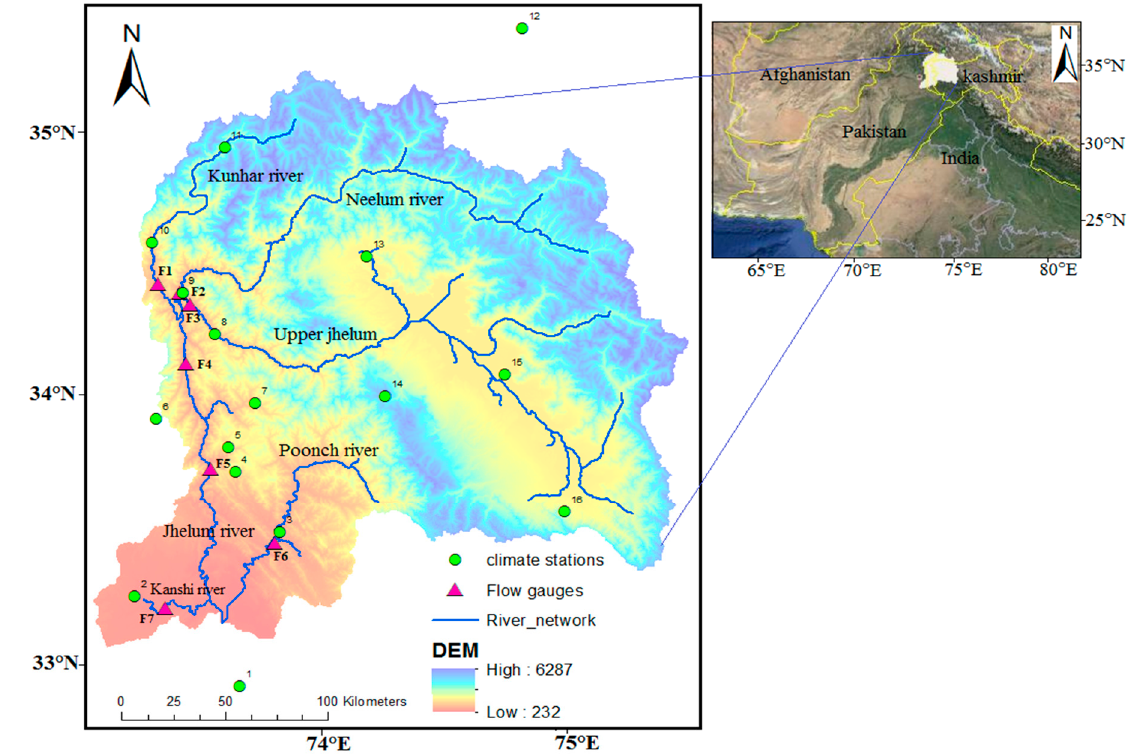
Figure 1. Location map of Jhelum River Basin and spatial distribution of weather and hydrological stations.